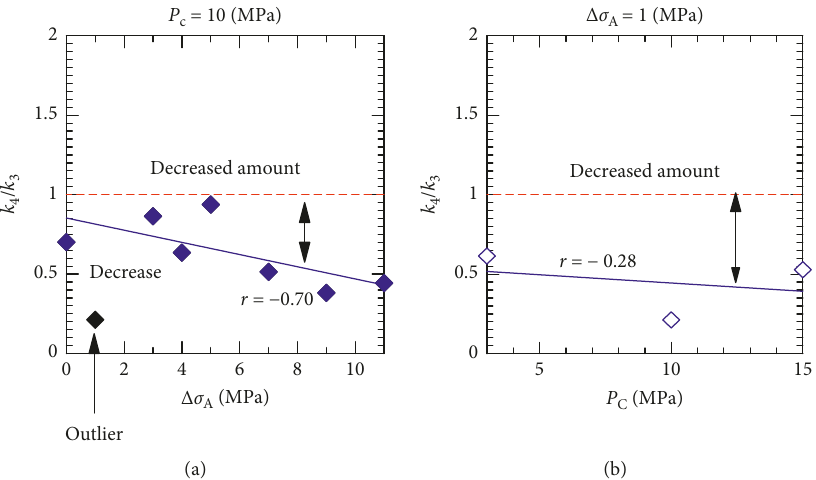
Figure 9: Permeability ratio vs. (a) axial stress disturbance amplitude and (b) confining pressure of the fractured